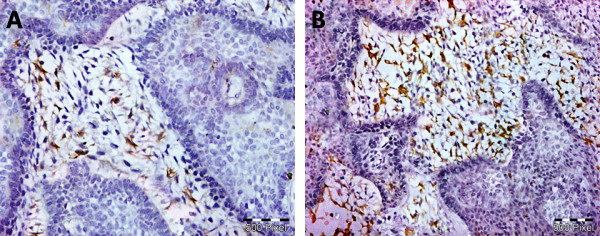
Stromal CD10 immunostaining (A) represents cytoplasmic and nuclear CD10 expression of mild intensity in about 15% of stromal cells. (B) represents CD10 expression of moderate to strong intensity in about 70% of stromal cells (immunoperoxidase X200).